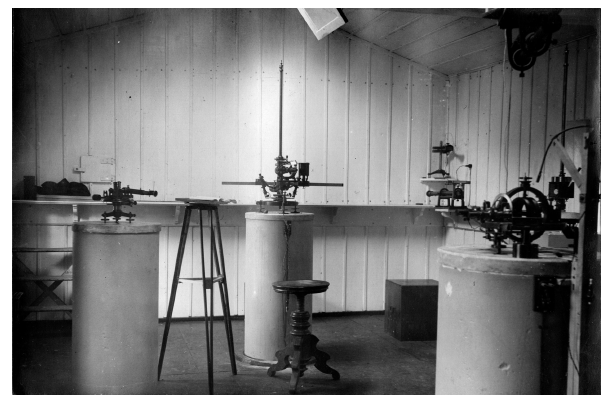
Figure 14. Basement of the brewery in Maisach called “Som- merkeller”. Pillars with the instruments for the measurement of tem- poral variations of the field.